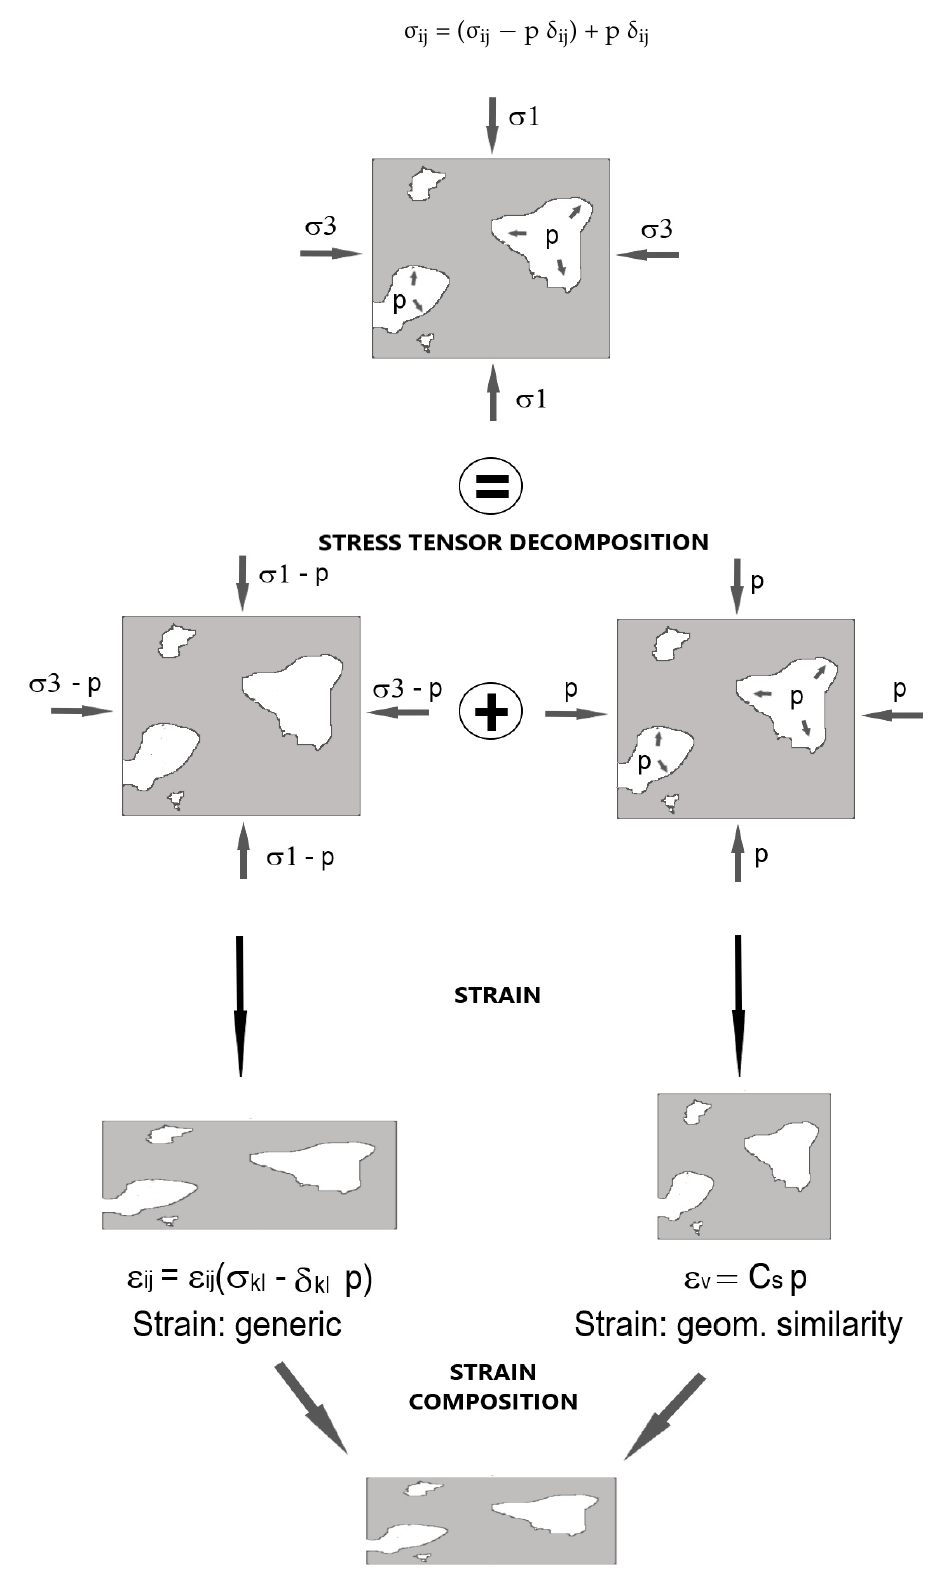
Figure 3. Stress tensor decomposition. 2. The stress field associated with the second term on the right side of Equation (14), (p δ ij ), which is now applied over Σ 1 and Σ 2 , i.e., the whole boundary surface, is a well-known solu- tion consisting of a uniform isotropic pressure equal to p (see Ref. [42]) for whatever bound- ary or pore surface shape, whereas the stress at a point associated with the first term ( σ ij − p δ ij ) is an unknown tensor, ψ 0 ij = ψ 0 ij ( σ kl − p δ kl ), which depends only on the differential stress ( σ kl − p δ kl ) (Figure 3). We are not interested in calculating the solution ψ ij for each point but at achieving information about its features, namely at comparing the local stress and strain fields in a porous medium subjected to a pore pressure, with those into an identical one in dry condition.